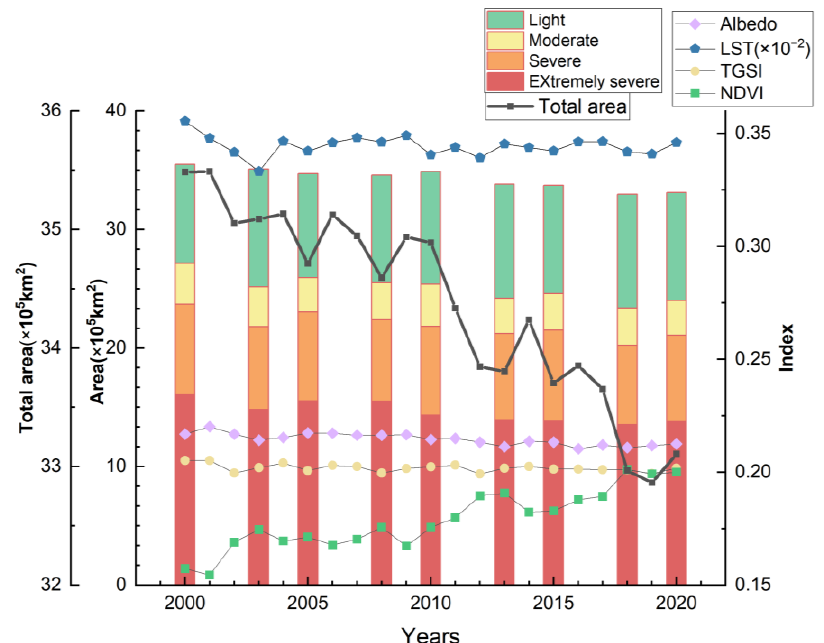
Figure 7. Desertification monitoring indicators and interannual variation of desertification area. Columns indicate the area of various types of desertification land, colored lines indicate the four monitoring indicators, and the black lines are the total area of desertification land.